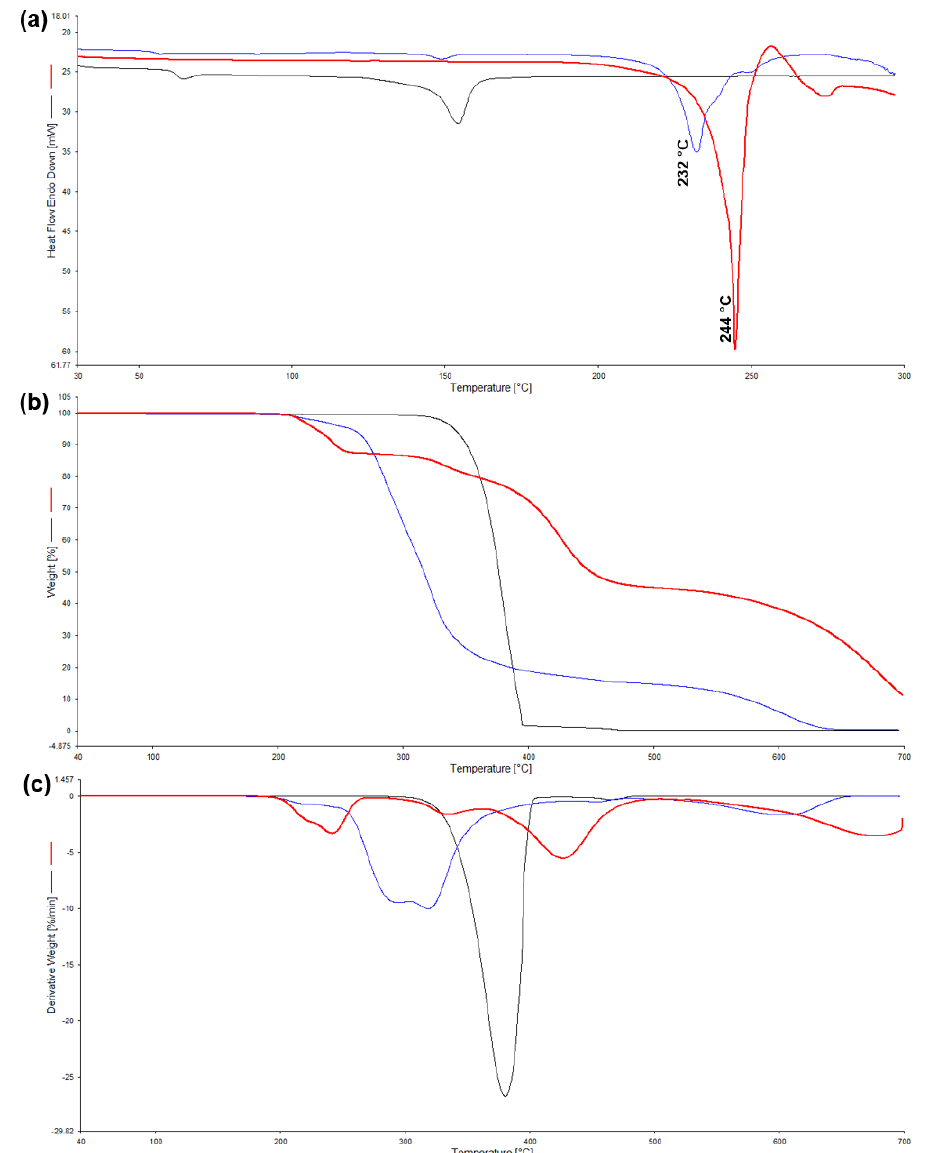
Figure 6. Thermal behaviour of PLA—DSC ( a ), TGA ( b ), and DTG ( c ) at a heating rate of 10 °C min − 1 . Fen (red), neat polymer (black), and physical mixture (blue).